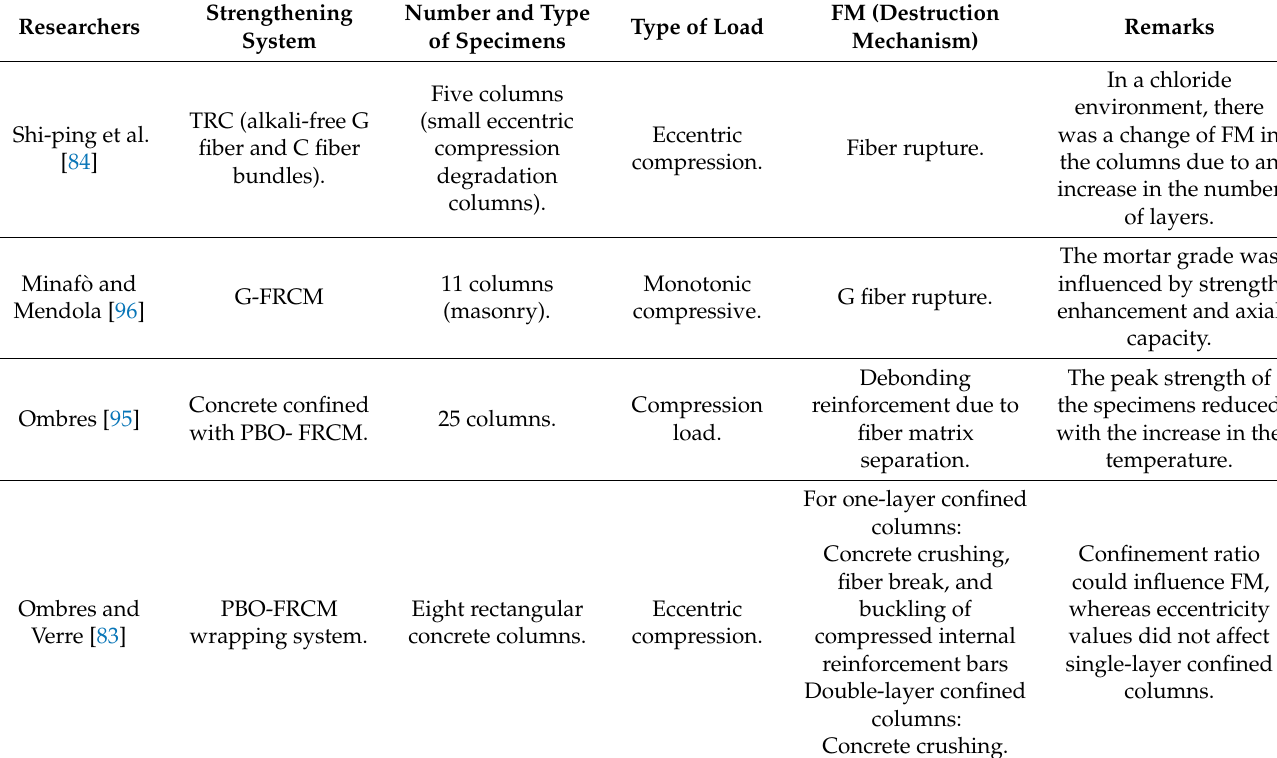
Table 12. An overview of studies on concrete columns strengthened with